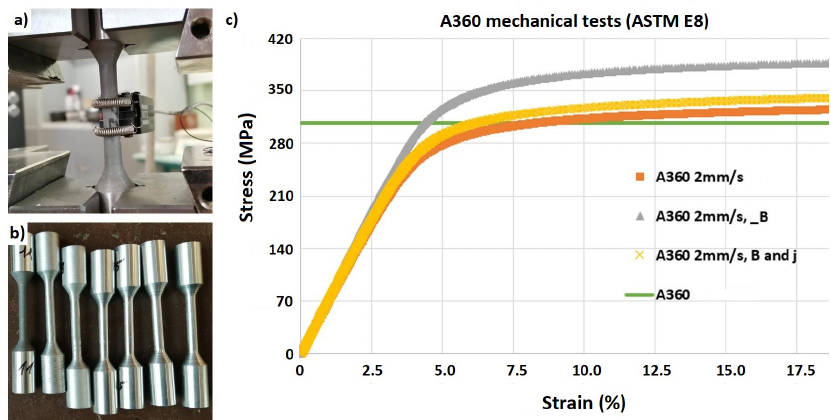
Figure 6. Mechanical test results: a) Elongation measurement sensor on the sample, b) Samples prepared according to ASTM E8 standard, c) Experimental results for different A360 samples.